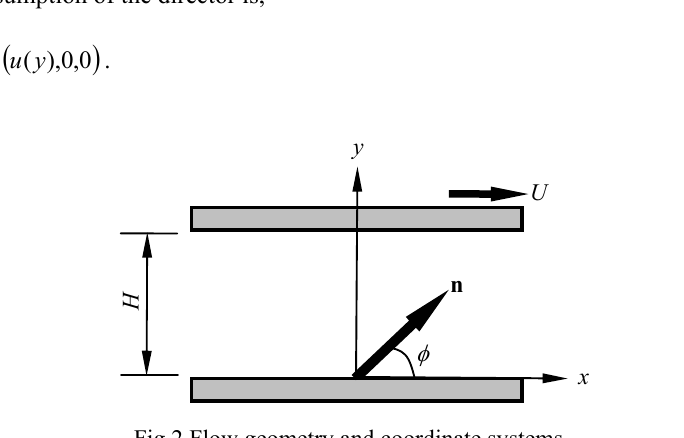
Fig.2 Flow geometry and coordinate